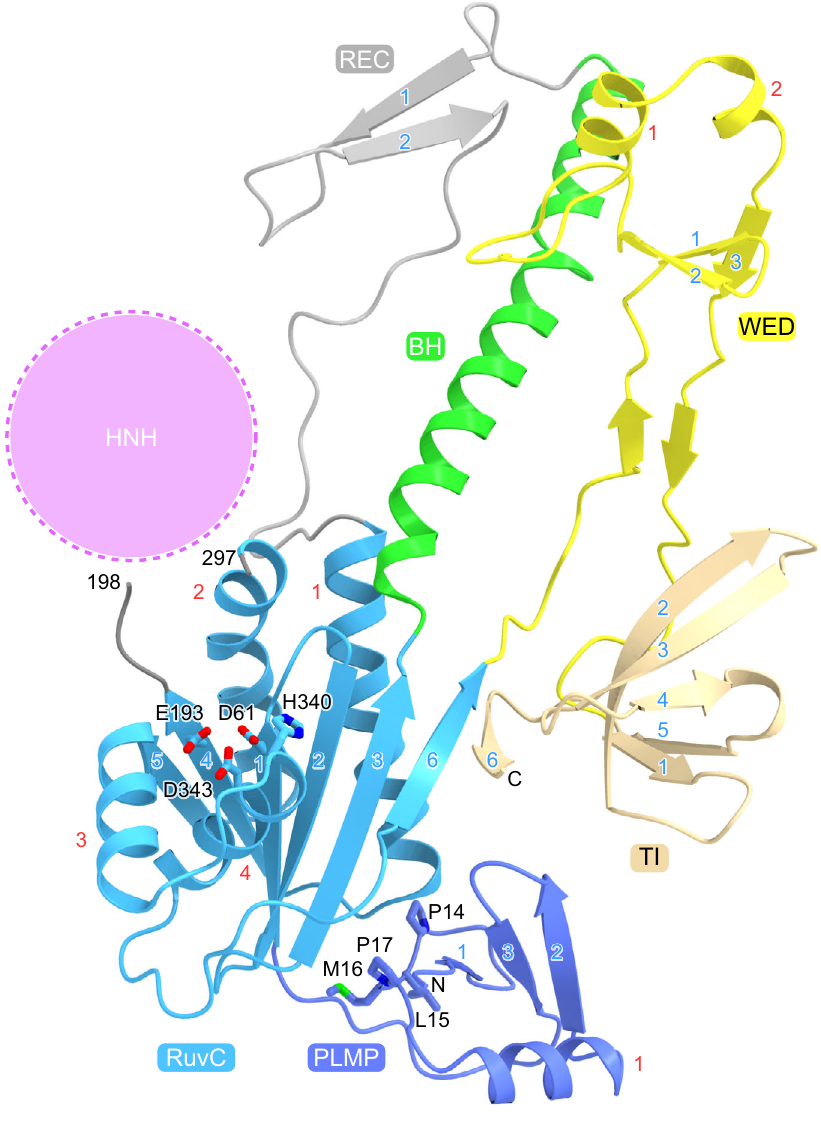
Fig. 2 | IscB structure. Theconserved catalytic residuesintheRuvC domainand the PLMPmotifin the PLMPdomain are shown asstickmodels. Thepossible location of the HNH domain is indicated by a dashed circle. The core α -helices and β -strands in each domain are numbered in red and blue,